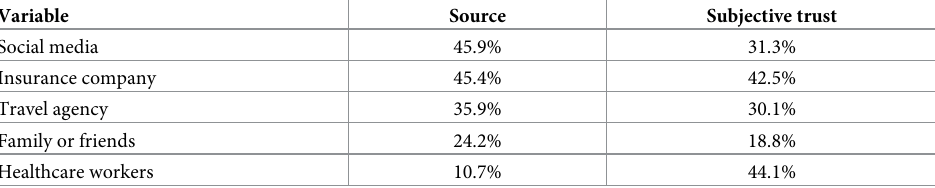
Table 4. Source and subjective trust of travel health insurance information (N =